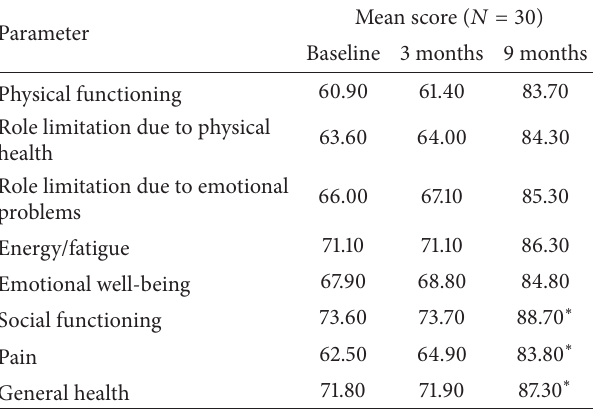
Table 4: Table showing changes in mean score of quality of life in operated